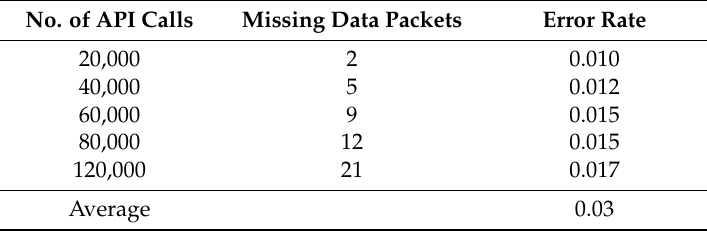
Table 2. The data acquisition process accuracy.